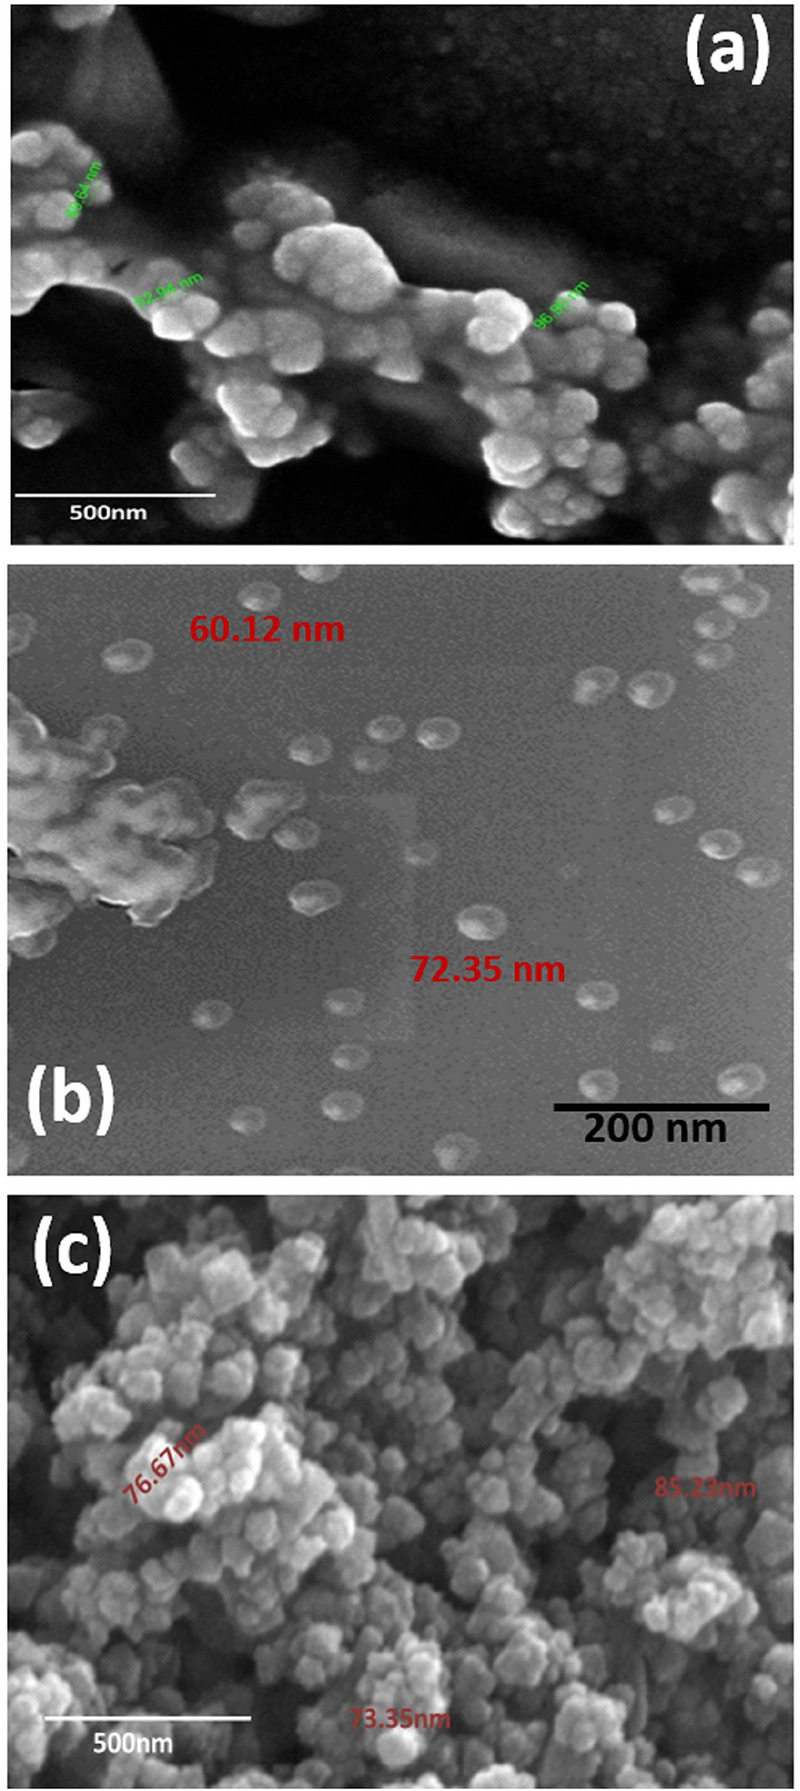
SEM micrograph of (a) GL-AgNPs, (b) SA-AgNPs, and (c) BR-AgNPs. GL indicates Glochidion lanceolarium, SA indicates Semecarpus anacardium, and BR indicates Bridelia retusa.